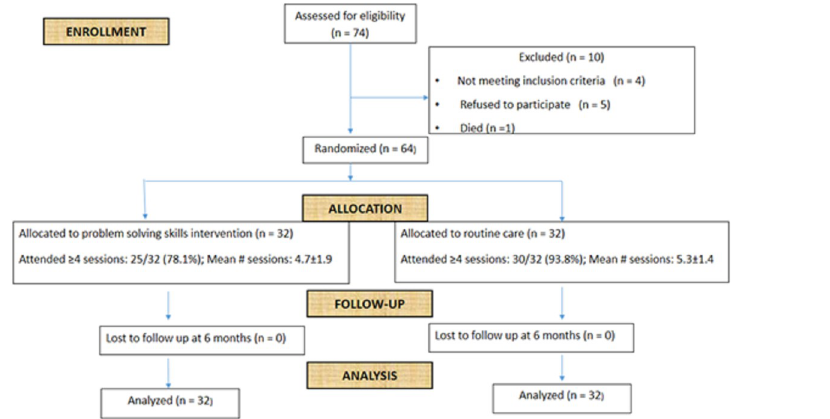
Fig 1. Consort diagram showing trial participant